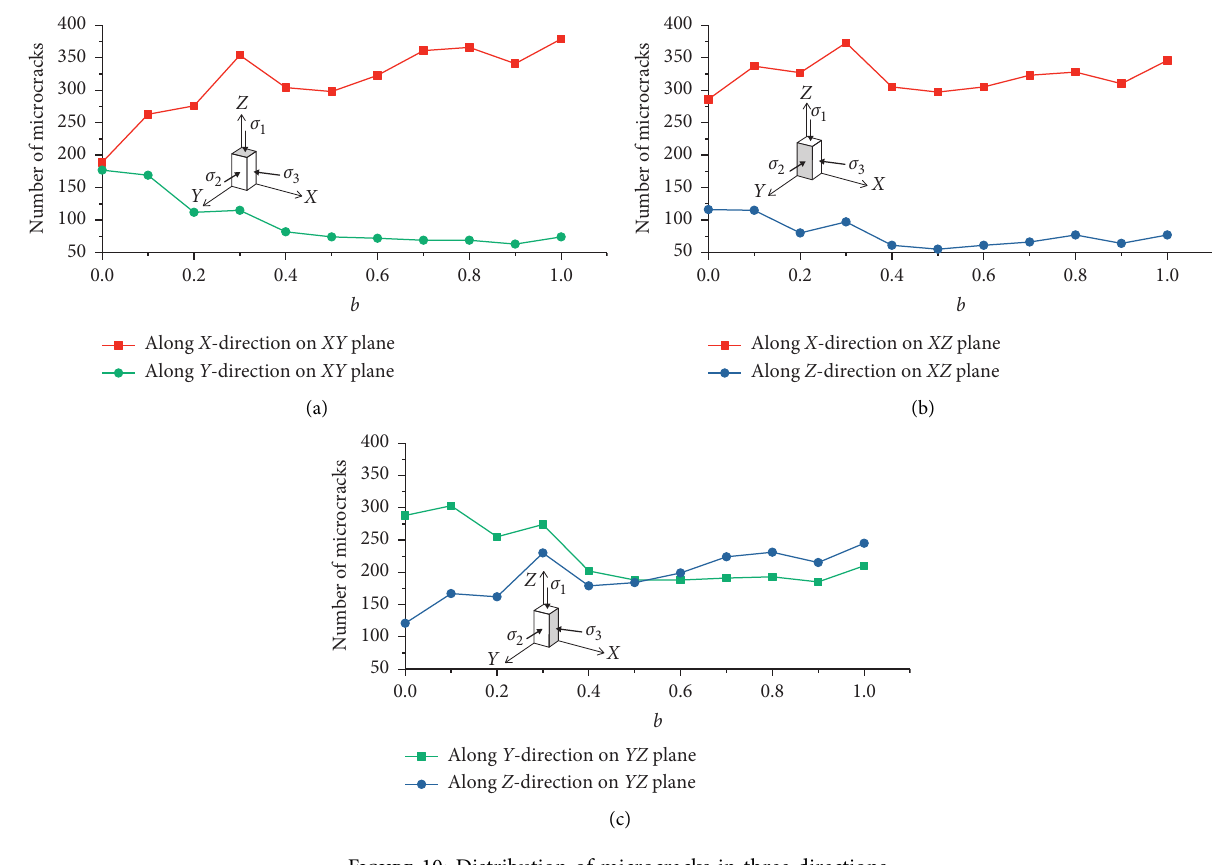
Figure 10: Distribution of microcracks in three directions.